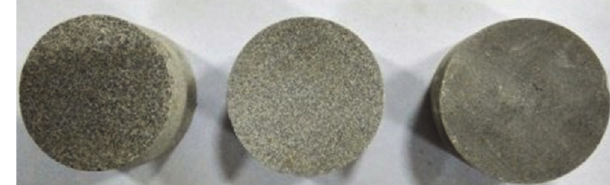
Figure 2: Three types of sandstones of Brazilian